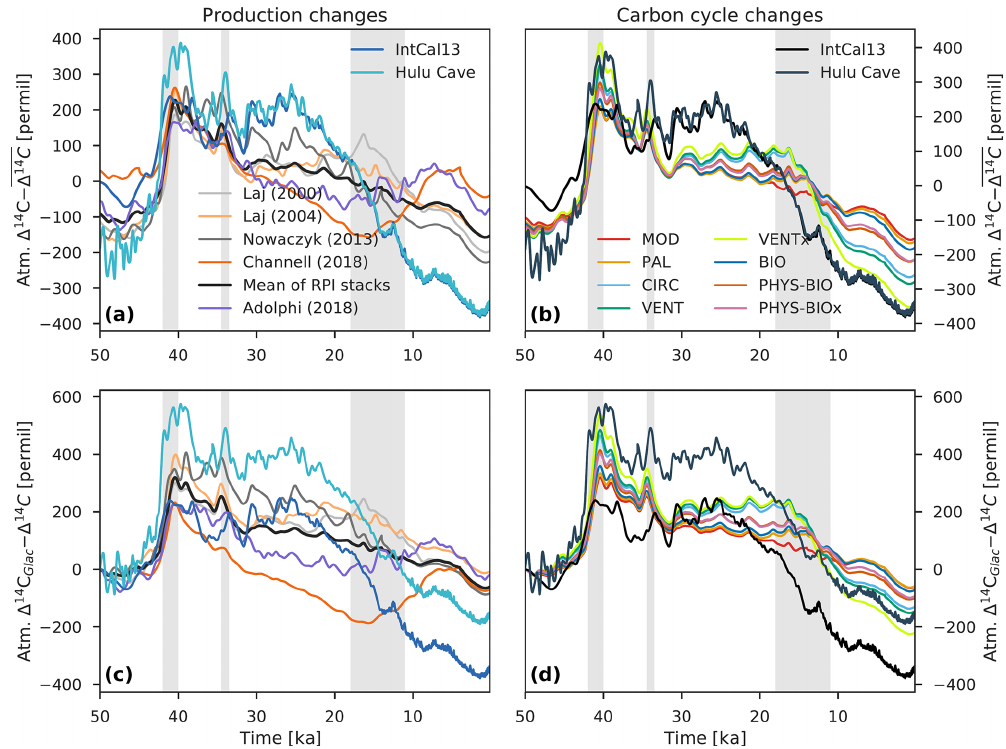
Figure 9. Comparison of atmospheric (cid:49) 14 C variability caused by changes in the ocean carbon cycle (b, d) with production-driven changes in atmospheric (cid:49) 14 C using scenario MOD (a, c) . For the analysis of carbon cycle changes, only the results of model runs using the mean paleointensity-based 14 C production rate are shown. The (cid:49) 14 C records in the upper panels (a, b) have been detrended by removing the mean, whereas the lower panels (c, d) show (cid:49) 14 C anomalies expressed as differences relative to the (cid:49) 14 C value at 50ka. Three vertical light gray bars indicate the Laschamp ( ∼ 41ka) and Mono Lake ( ∼ 34ka) geomagnetic excursions, as well as the last glacial termination ( ∼ 18 to